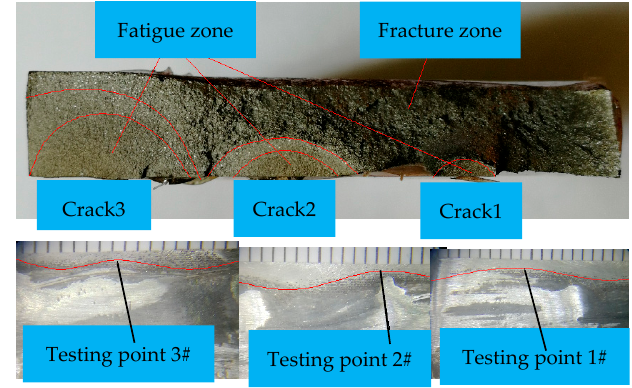
Figure 16. Comparison of cracks position and testing points.